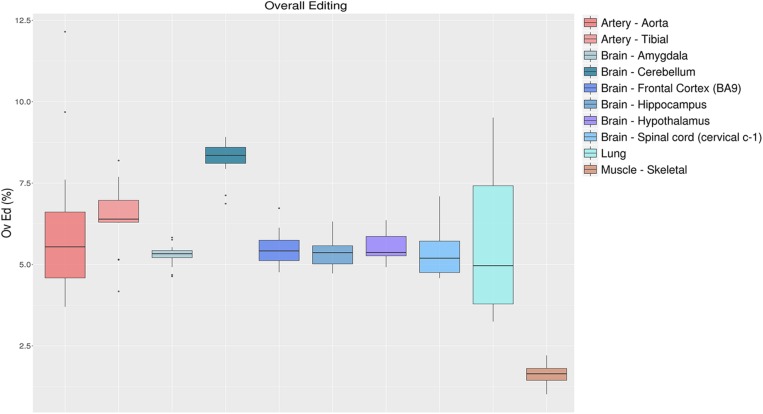
Overall editing levels in 10 selected “body sites” from the GTEx project. Each box plot represents samples from one tissue type. The overall editing level is defined as the percentage of edited nucleotides at all known editing sites. Cerebellum and skeletal muscle emerge, respectively, as the most edited tissue and the less-edited tissue among the analyzed tissues.